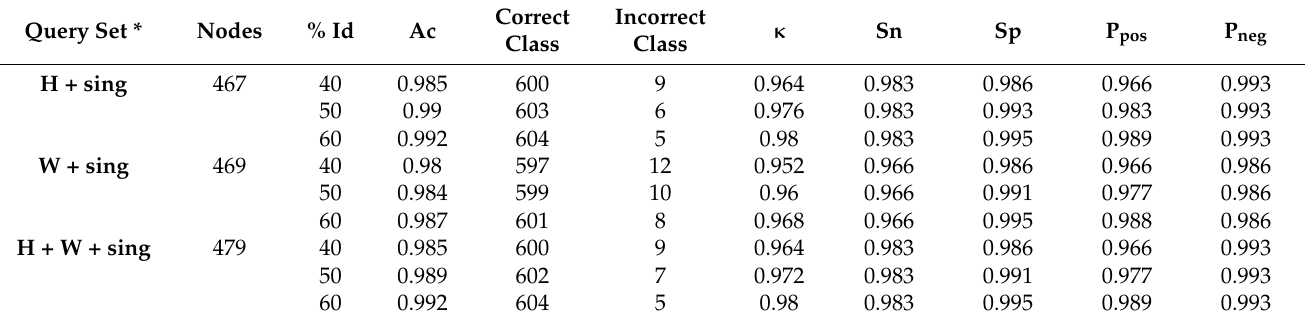
Table 4. Statistical analysis for the performance of the best 9 SSMs on the target Main90